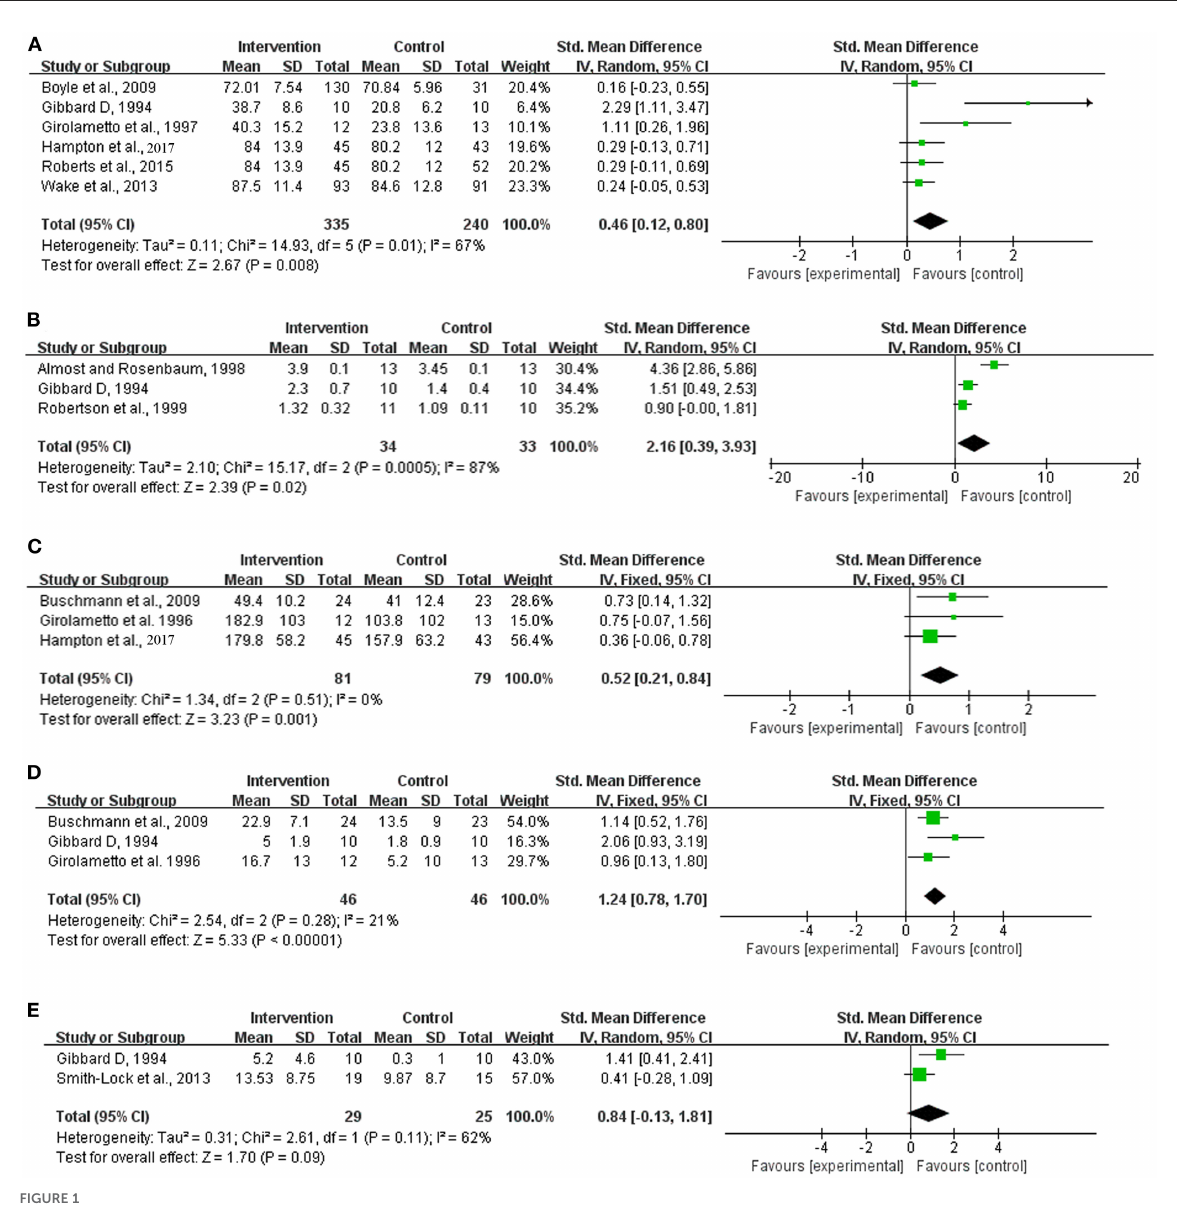
FIGURE1 Meta-analysis outcomes of the intervention for expressive language development. (A) Overall expressive language; (B) Mean length of utterances in a language sample; (C) Number of utterances in a language sample; (D) Parent reports of expressive phrase complexity; (E) Expressive grammar ability. Control, no or delayed